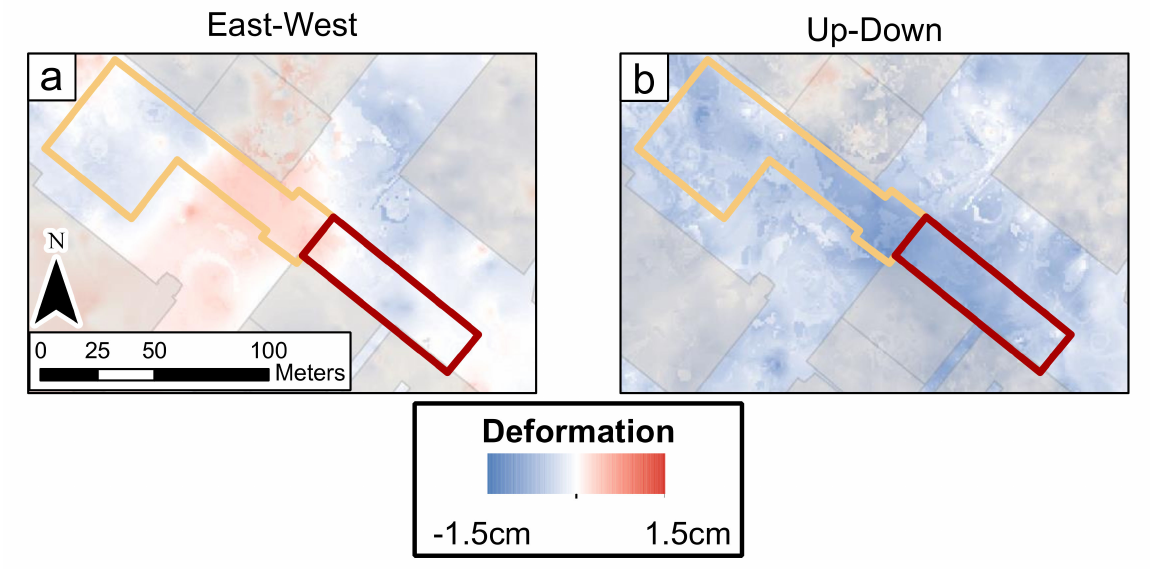
Figure 11. ( a , b )Vertical and East-West horizontal deformation spanning the final portion of crossover cavern excavation from 27 February 2019 to 3 July 2019. Displacement measured by combined Sentinel-1 and COSMO-SkyMed